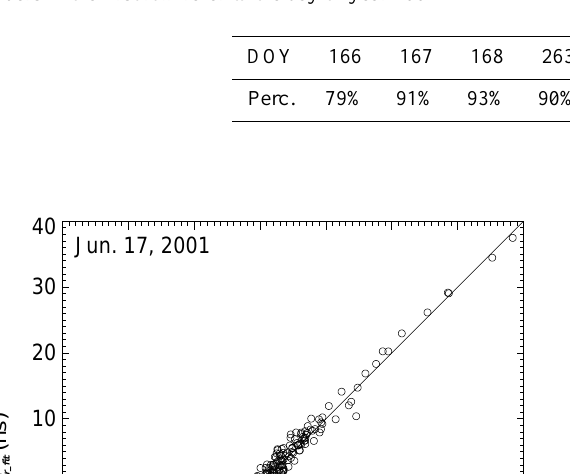
Table 2. The percentage of the difference within ± 2ns between the GEONET derived receiver bias and single receiver fitted bias. The